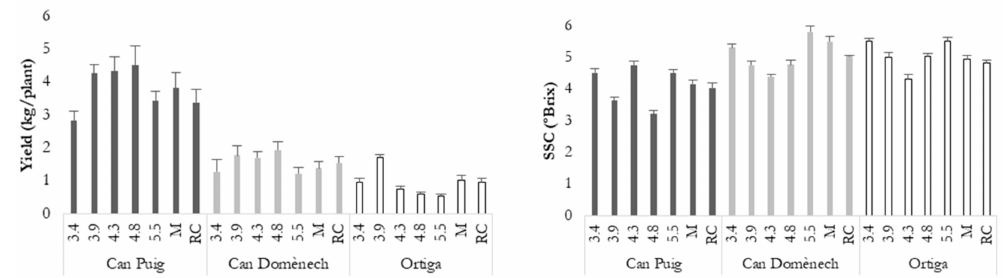
Figure 3. Mean values per genotype and locality for yield and soluble solids content (SSC). Bar errors represent the standard error of the mean. Experimental lines: 3.4, 3.9, 4.3, and 5.5. Controls: M (Mando), RC (Rosa Candido).